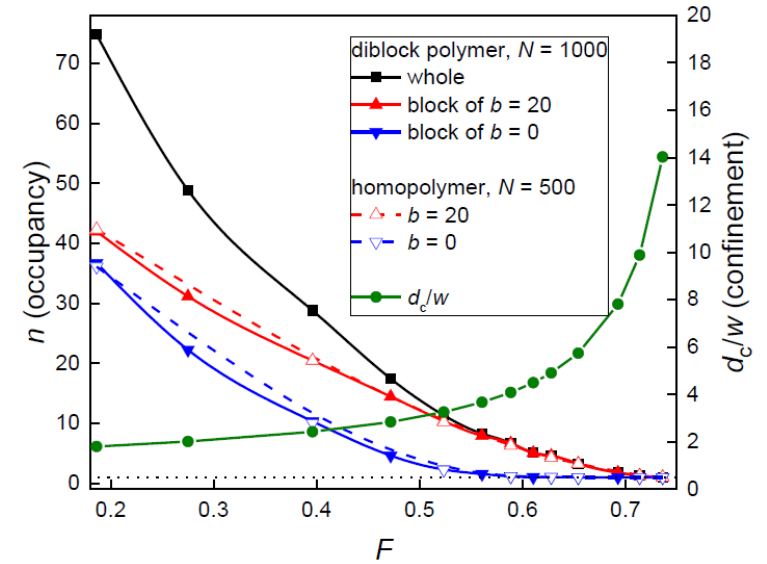
Figure 6. Occupation number n of a diblock chain, its blocks and homopolymer chains corresponding to the blocks together with the confinement ratio d c / w as functions of the filling fraction of posts F for constant narrow passage width w = 2.